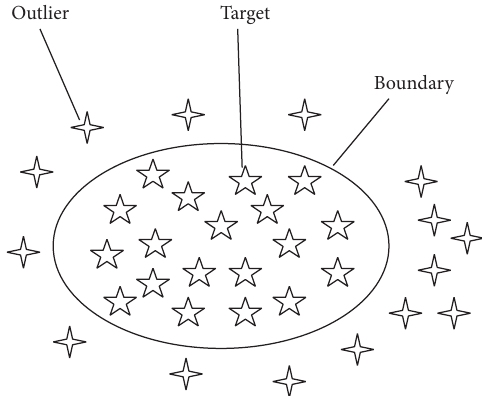
Figure 4: Schematic of the two-dimensional